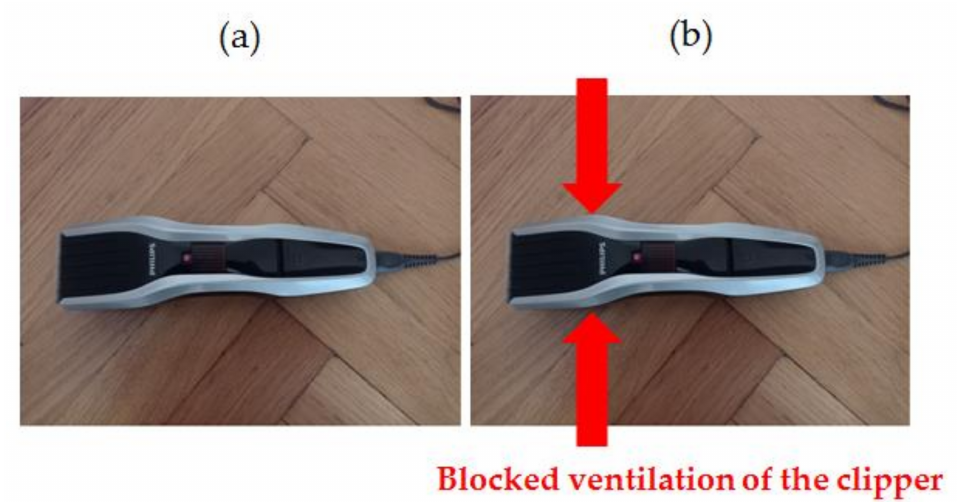
Figure 7. Blocked ventilation of the BLDC motor at 2100 rpm ( a ) gray-scale, ( b ) iron scale, ( c ) rain- bow scale.